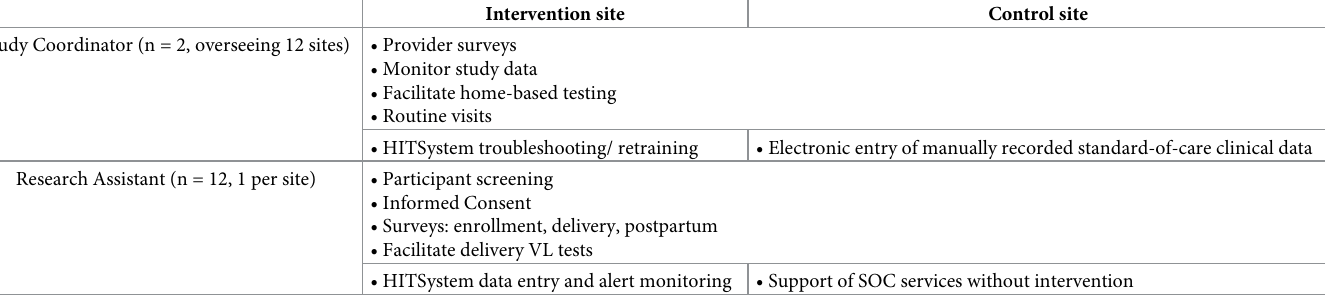
Table 2. Study staffing and activities at intervention and control